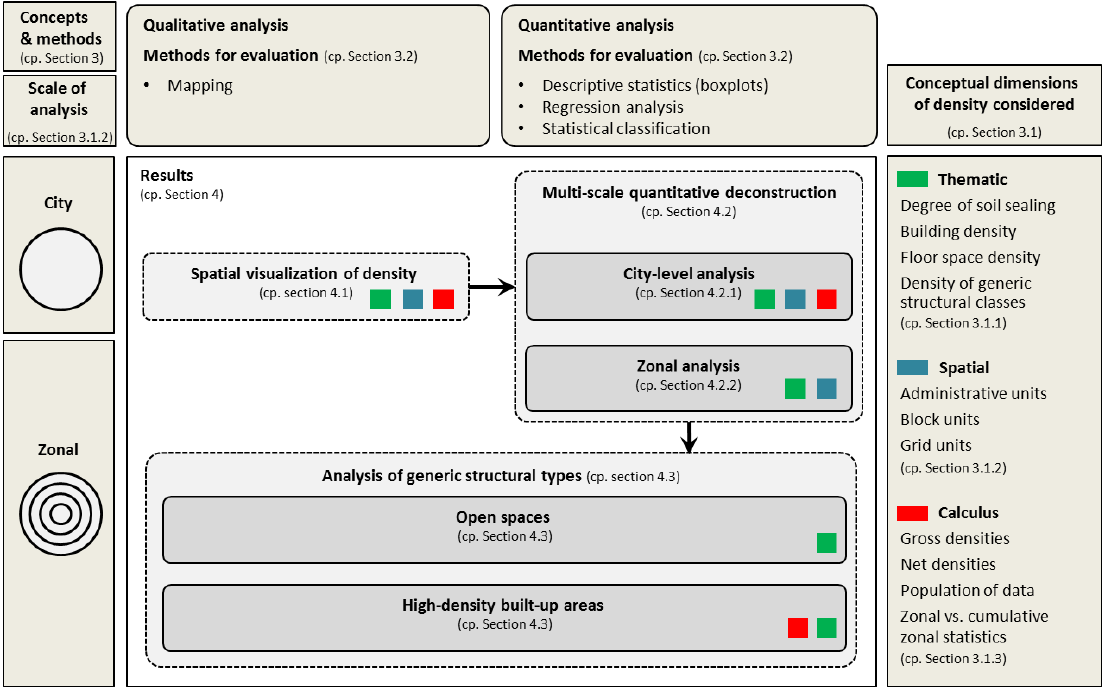
Figure 2. Conceptual framework for a qualitative and quantitative deconstruction of physical urban density.